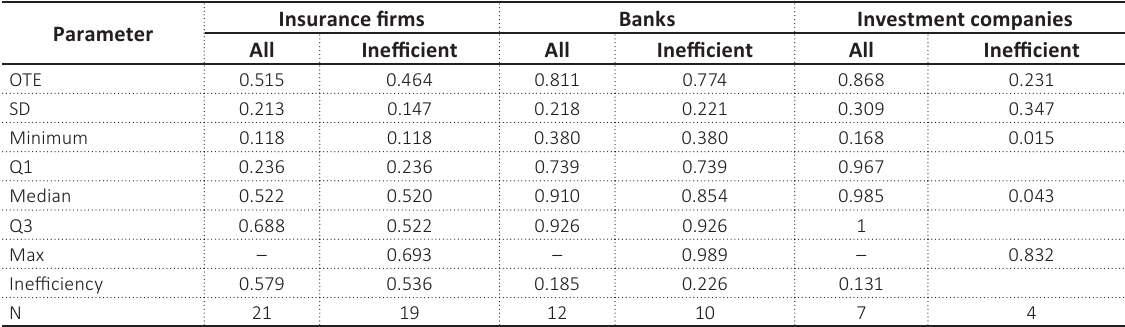
Table 5. Descriptive statistics for the technical efficiency